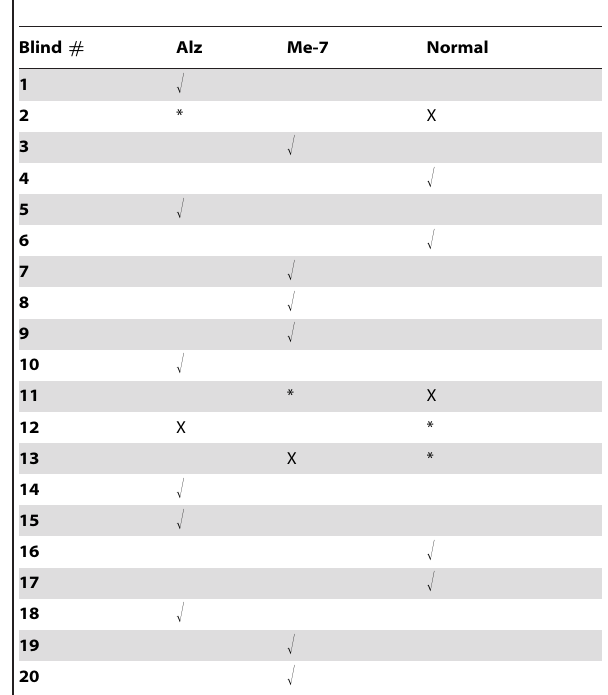
Table 4. Classification results applying the 20 protein Disease Discriminant Classifier to 20 naı¨ve samples obtained when the disease stage of the test set mirrored that of the training